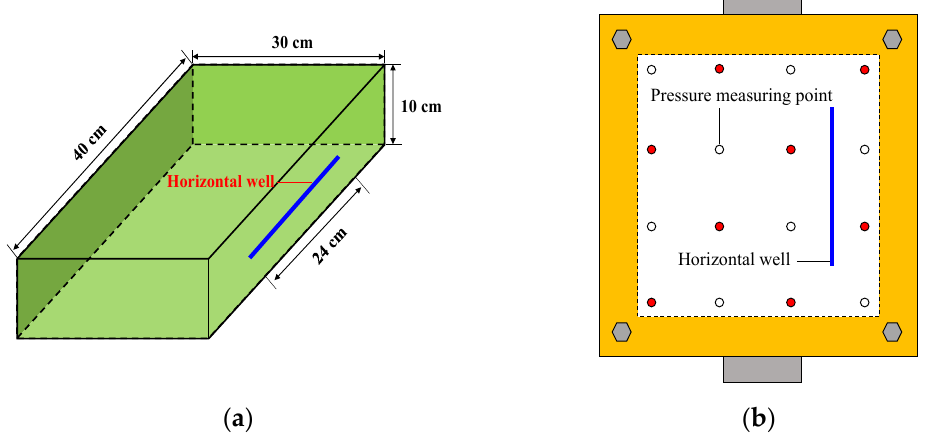
Figure 1. Three-dimensional physical model: ( a ) the model profile; ( b ) the pressure measuring point.